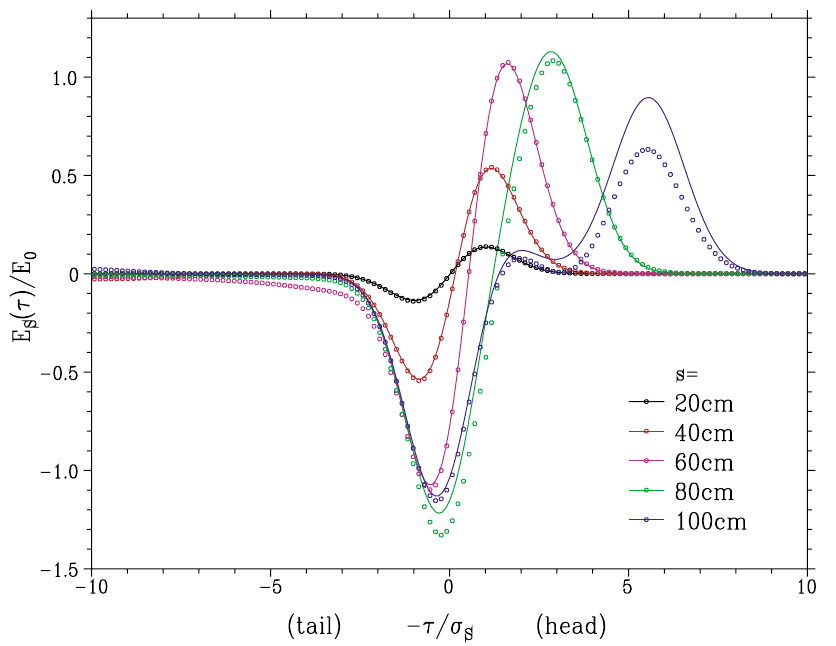
FIG. 4. (Color) The longitudinal electric field E The other parameters are the same as in Fig.